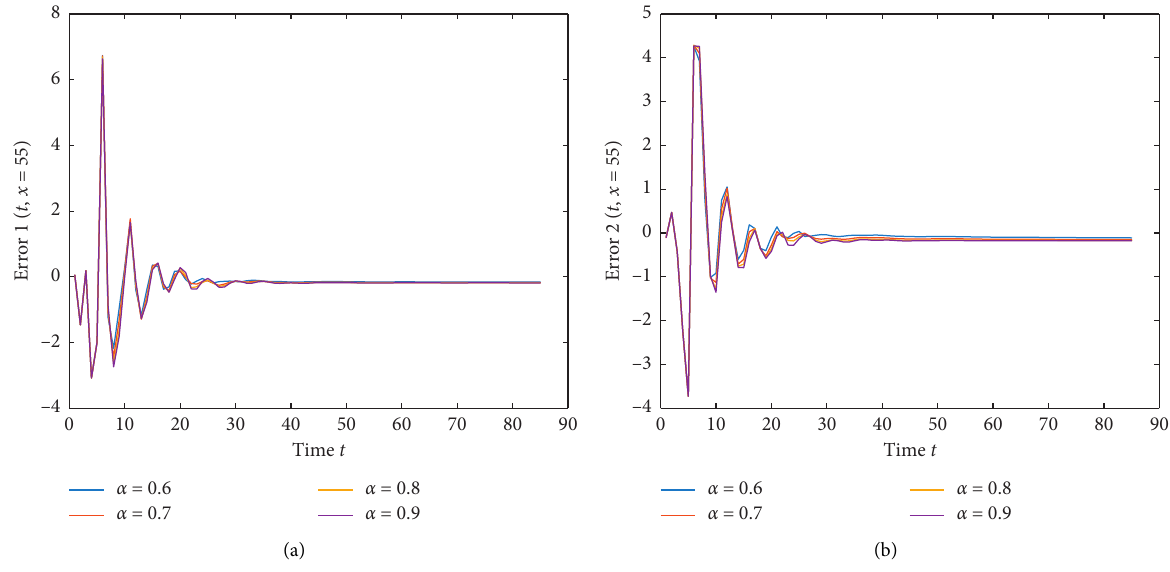
Figure 7: Trajectories of error system (26) at spatial position x � 55 under different orders.